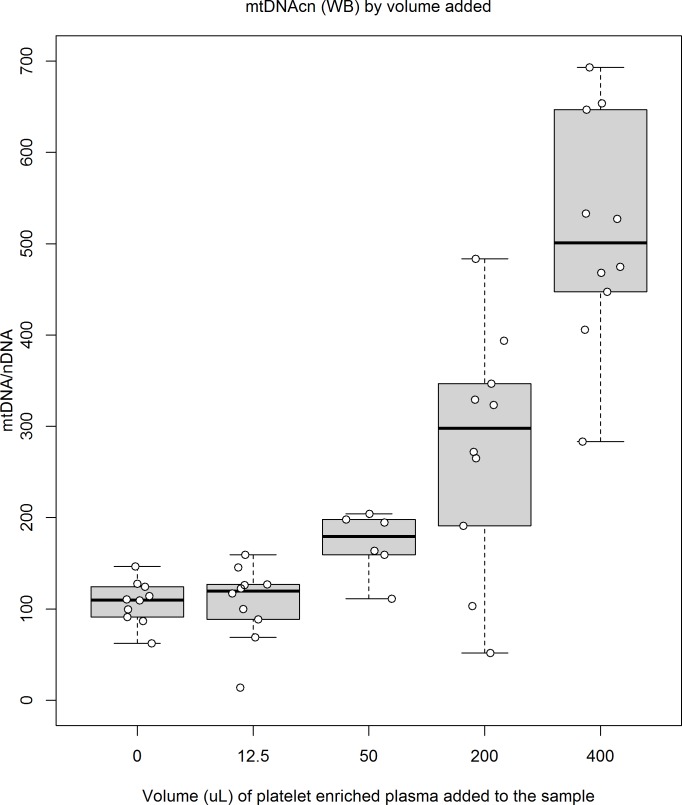
MtDNAcn(WB) of blood preparations supplemented with different amounts of platelet-enriched plasma and saline solution.All preparations combined 50 uL of blood, plus platelet-enriched plasma and additional saline solution to reach a volume of 450 uL. Each box corresponds to a different combination (p1—p5, see Table 1) and summarizes data from 10 preparations (one from each original blood sample) except in p3 (50 uL of platelet-enriched plasma), which only summarizes 6 preparations. Altogether, data from 46 preparations are shown. Individual mtDNAcn(WB) for each preparation are plotted as white circles.